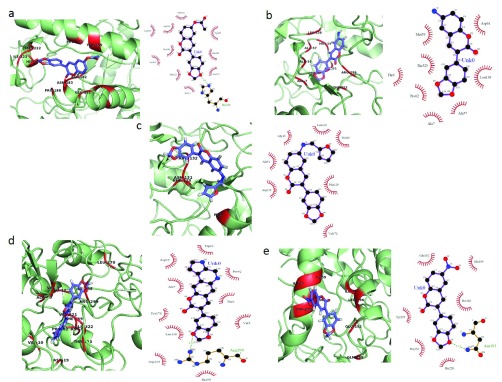
Binding modes of IPCS-ligand complexes.The interaction of the ligand within the IPCS inhibitor complex post MD simulation is shown the figure
a) IPCS - compound 1 complex
b) IPCS - compound 2 complex
c) IPCS - compound 3 complex
d) IPCS - compound 4 complex and
e) IPCS - compound 5 complex. MD simulation was performed for a time period of 10ns. Interacting residues are represented in red.